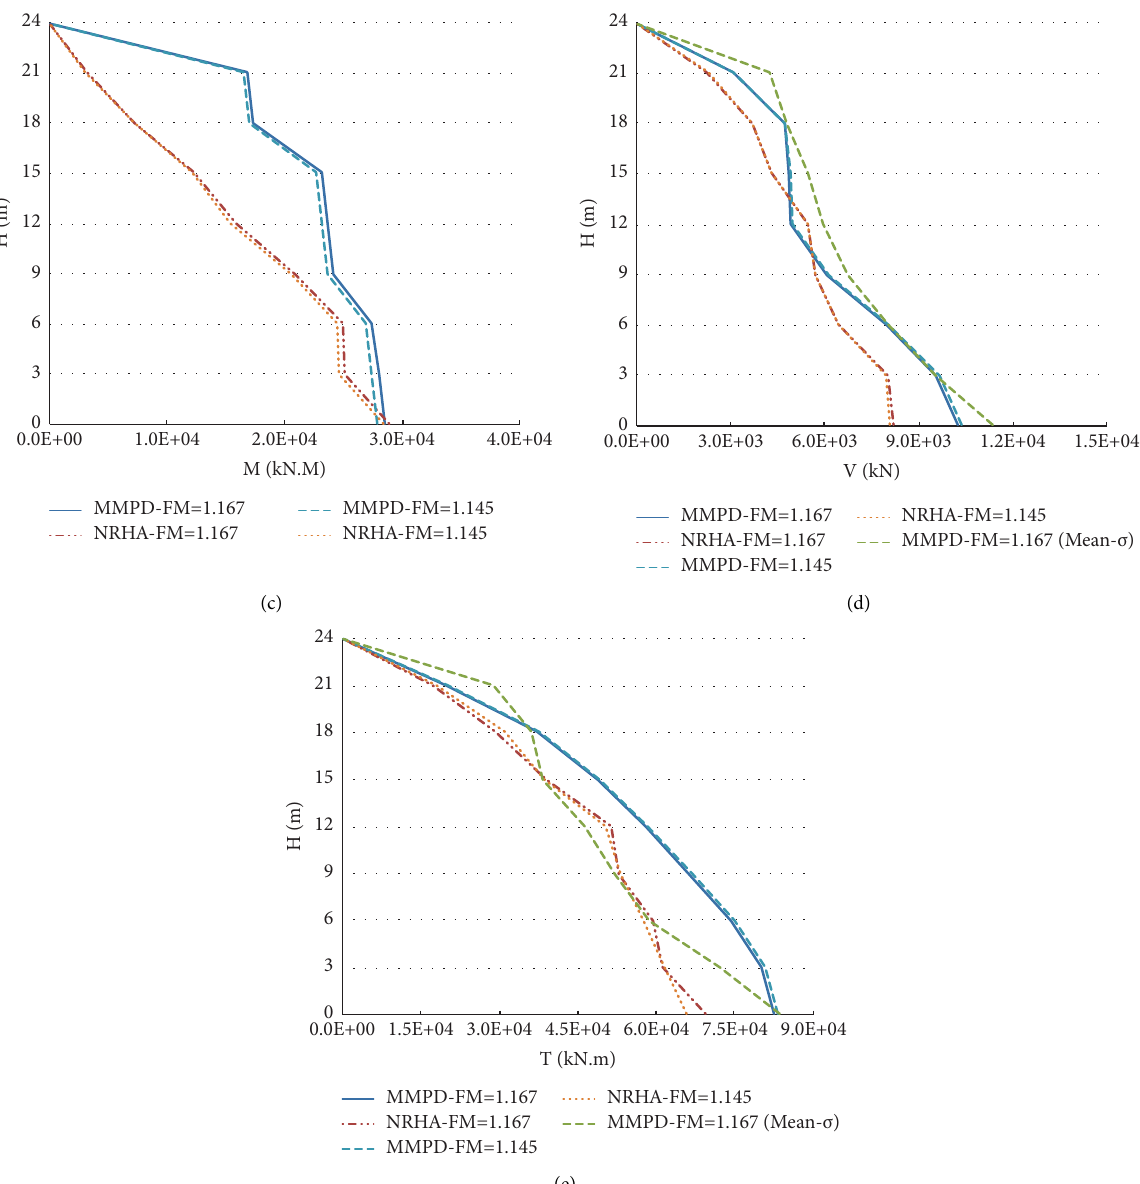
Figure 18: Building B2 under BIGBEAR record with diferent distributions of reinforcements. (a) Comparison between NRHA and inter- story drifts limit. (b) NRHA fexural moment demands and MMPD fexural capacities of 30cm wall. (c) NRHA fexural moment demands and MMPD fexural capacities of 20cm wall. (d) NRHA/approximated MMPD shear demands. (e) NRHA/approximated MMPD torsional